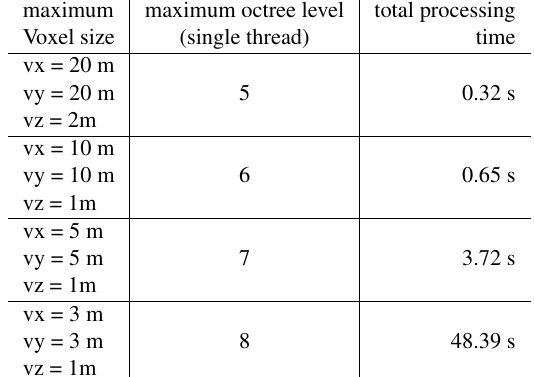
Table 1. Computation time, evaluated on an Intel Core